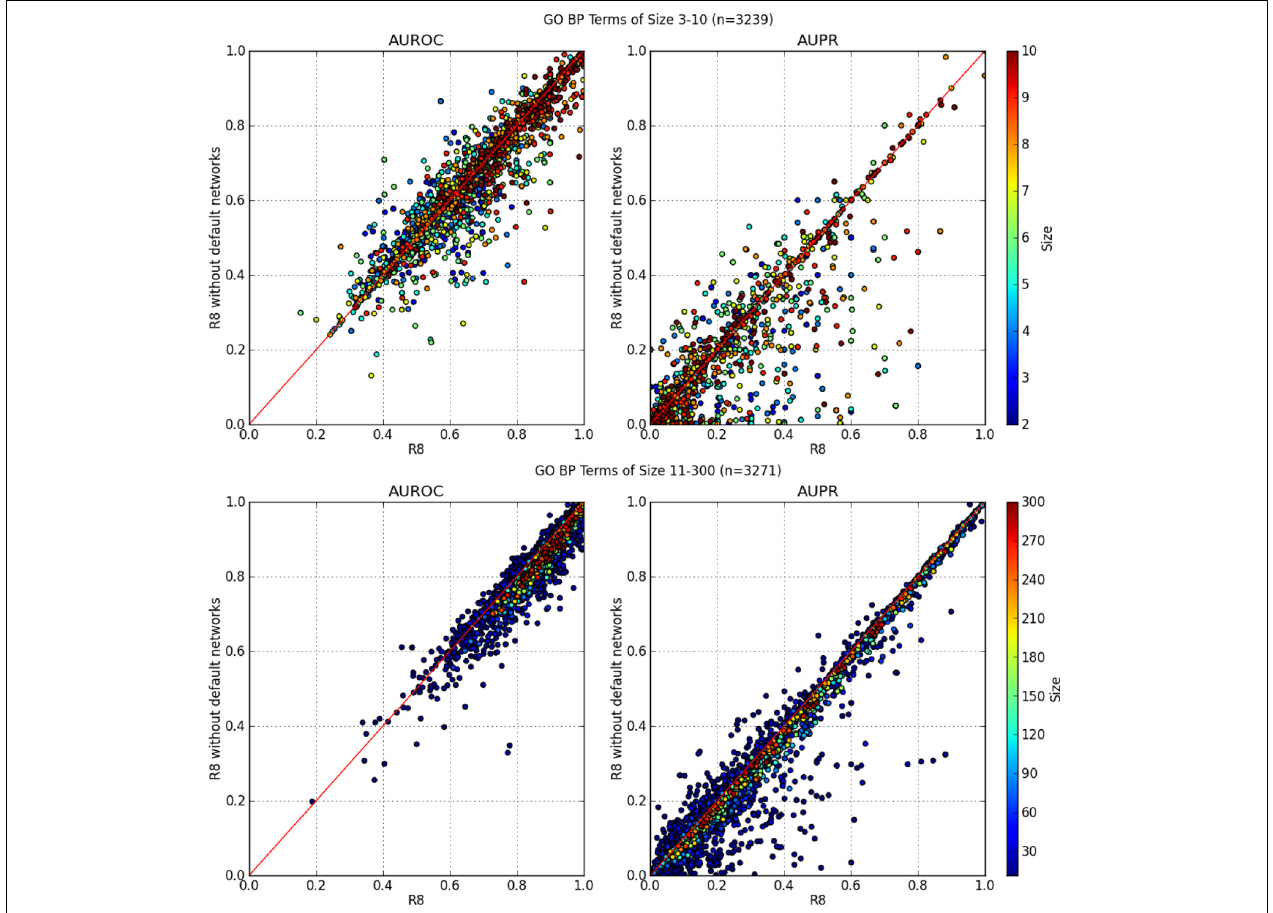
FIGURE 3 | AUROC and AUPR performance of each GO term. X-axis denotes performance using all networks from R8 while the Y-axis is R8 without default networks. GO terms containing 90 genes or more consistently performed better using all networks from R8.